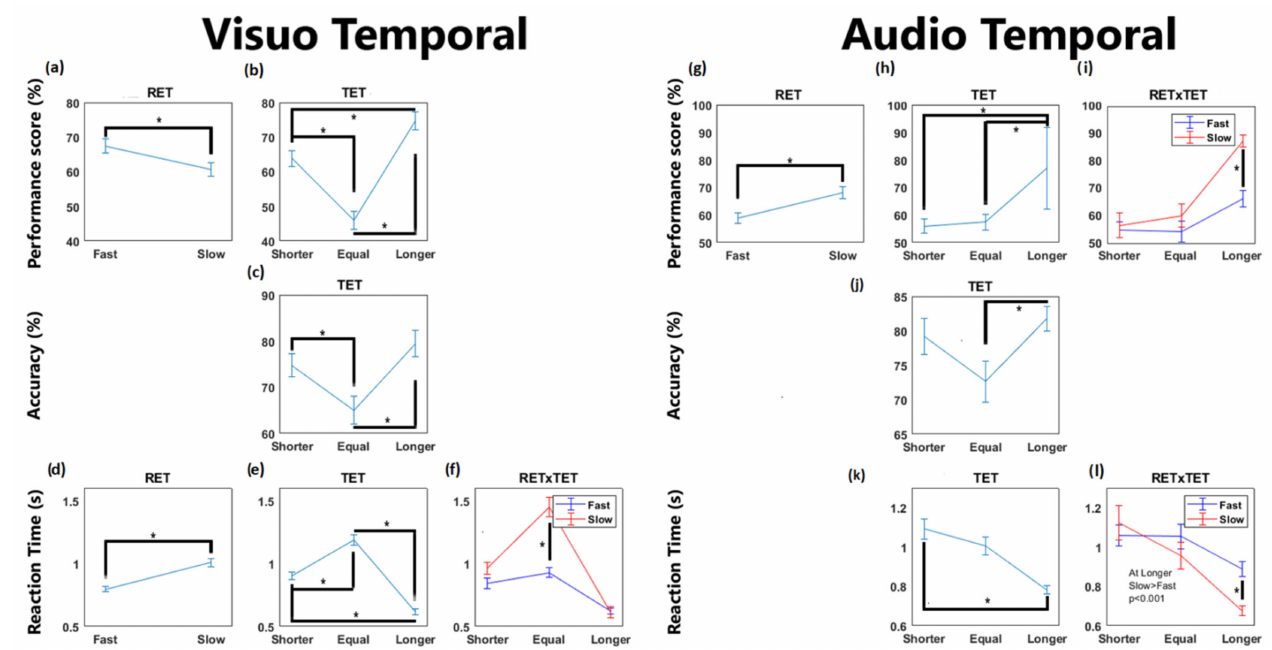
Figure 2. Participants’ performance score, accuracy and reaction time for visual temporal task and Audio temporal task. RET scores are represented both for VTT ( a , d ) and ATT ( g ). The panels show results over the TET conditions, both for VTT ( b , c , e ) and ATT ( h , j , k ). RET × TET scores are presented for VTT ( f ) and ATT ( i , l ). Asterisks indicate significant results ( p = 0.05), corrected for multiple comparisons. Error bars represent average and standard deviations. Note: The figure does not show plots for non-significant results. The factor age was not significant in any of the above